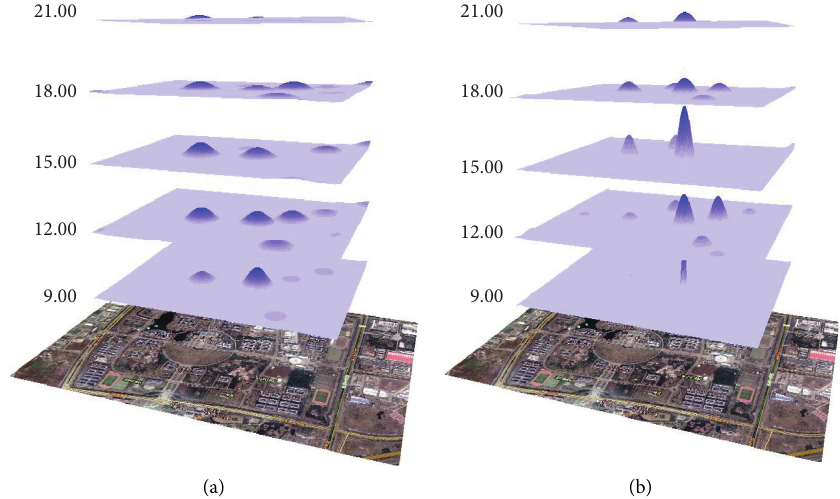
Figure 10: Density distribution of dynamic activity points on (a) weekends and (b) weekdays.